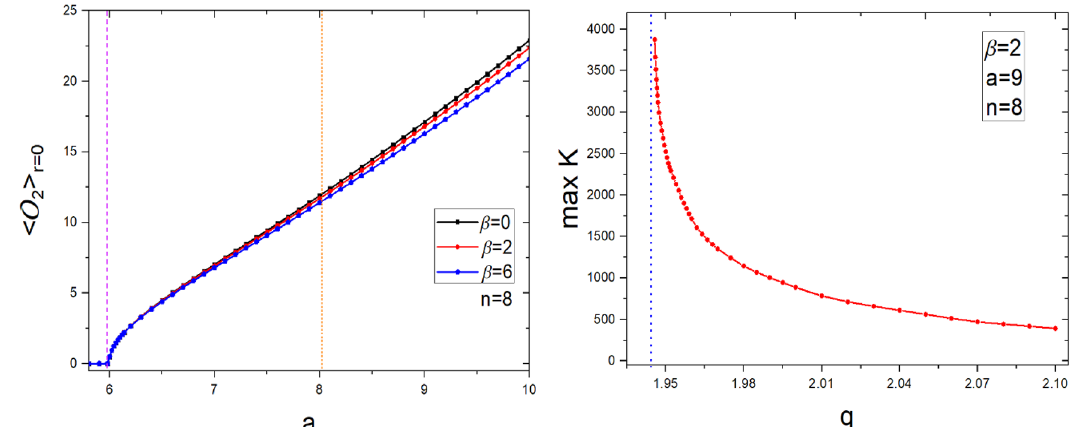
Figure 5 . hO 2 i as a function of r , for several values of β ( left ) and a ( right ).